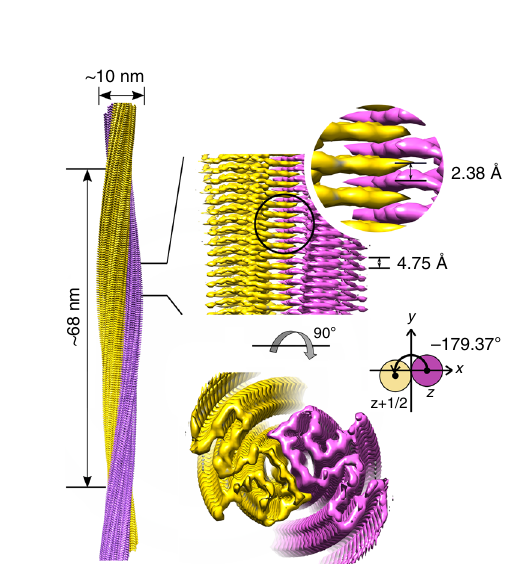
Fig. 2 Cryo-EM 3D reconstruction density map of the Ac-E46K α -syn fi bril. Fibril width, length of half pitch (180° helical turn), helical rise and twist angle are indicated. The twist angle is graphically illustrated. The two intertwining proto fi laments are colored in yellow and purple, respectively. Graphing was performed with UCSF Chimera